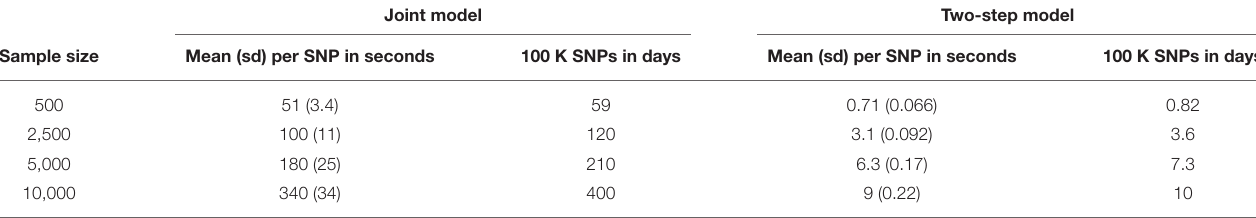
TABLE 2 | Approximate computational times using function “ system.time ” of R